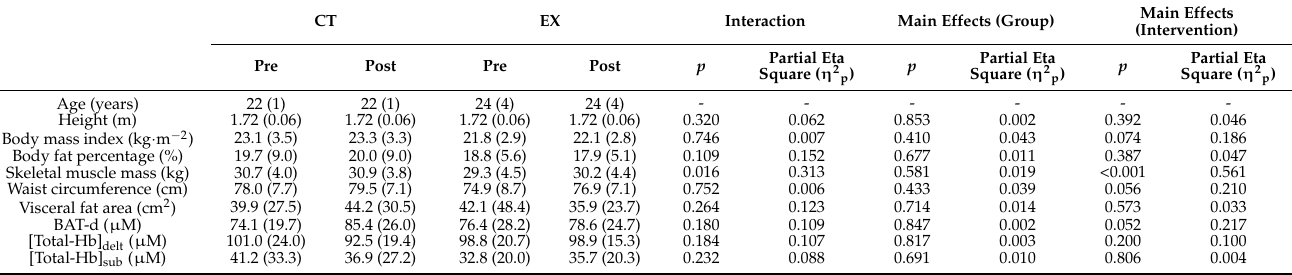
Table 1. Participant body composition.